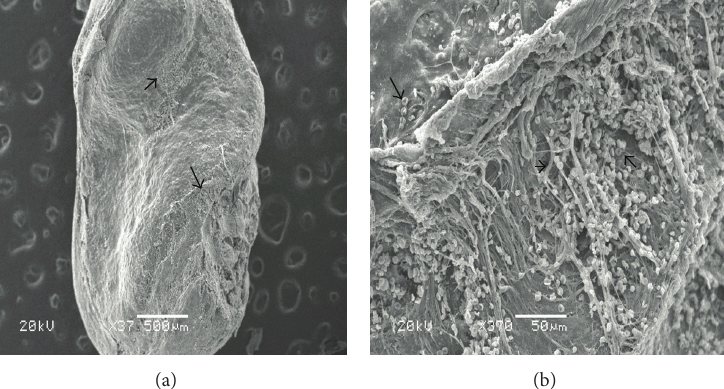
Figure 3: This image shows a middle ear sample surface. Specimen was taken from a patient undergoing surgery for chronic otitis media with cholesteatoma. This sample appeared to be biofilm positive showed at low magnification, but erythrocytes (arrows) were seen as magnification